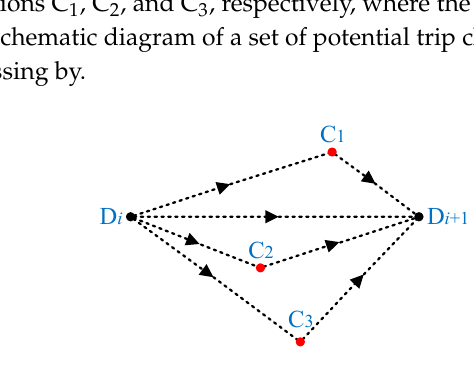
Figure 6. A journey with four potential routes.